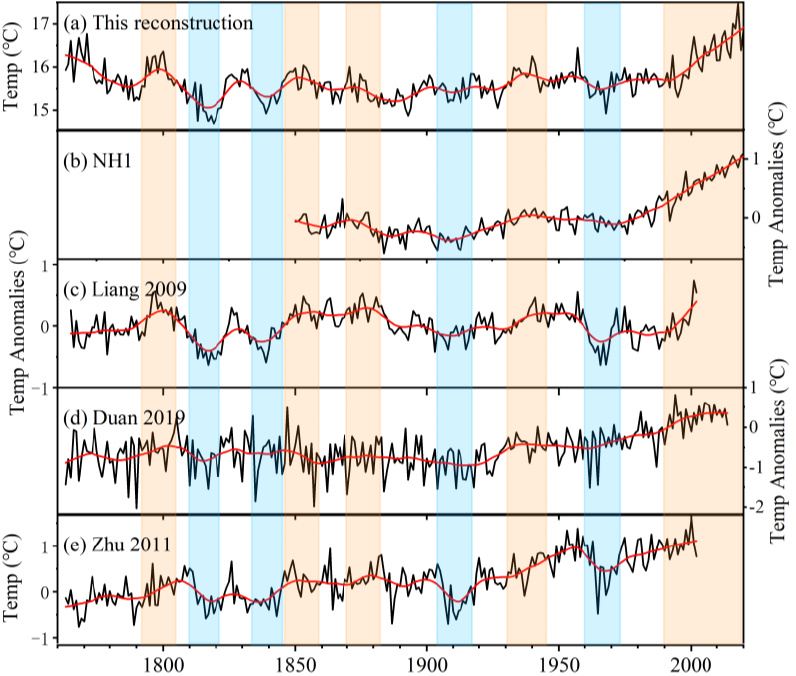
Figure 7. Comparisons of the July mean temperature reconstruction ( a ) with temperature series in the Tibetan Plateau (TP) ( c , d ) and Northern Hemisphere (NH) ( b ) temperature series; ( b ) Northern Hemisphere’s land surface July temperature from CRU; ( c ) June–August mean temperature reconstruction in the Sygera Mts. in southeast TP [18]; ( d ) MXD–based August–September mean temperature reconstruction in southeast TP [39]; ( e ) August mean temperature reconstruction in southeast TP [14].